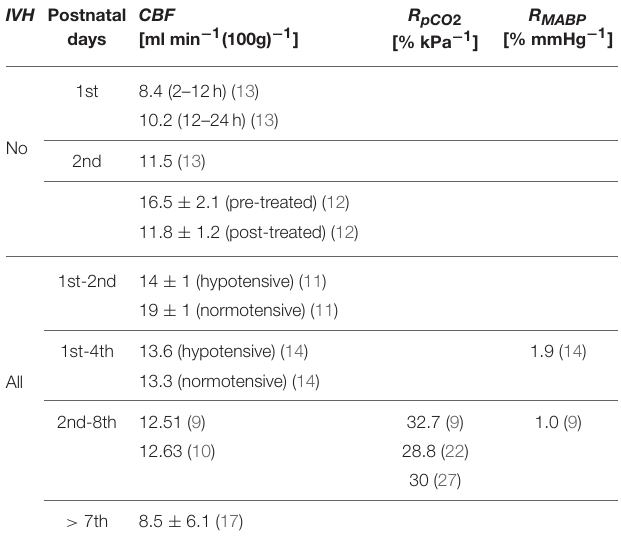
TABLE 5 | Numerical values of CBF and its reactivity to pCO 2 (R pCO WG IVH Number of